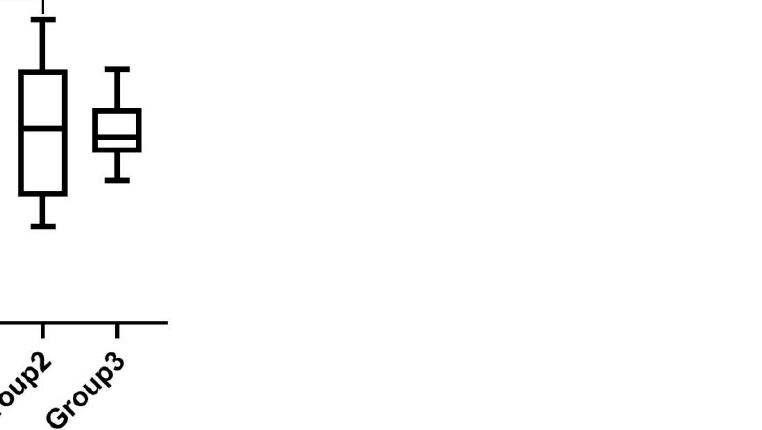
Figure 12. Standard deviation of driveway offset in speeding task. * indicates significant difference ( p < 0.05). ** indicates significant difference ( p < 0.01).